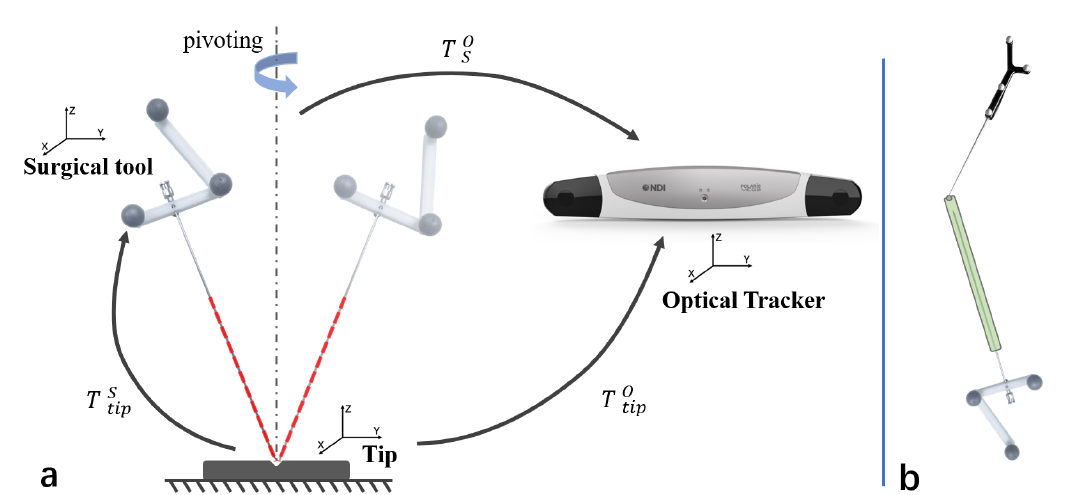
Figure 7. Calibrate the puncture needle. ( a ) Pivot the needle to find the offset of the tip; ( b ) Find the axis’ direction using the